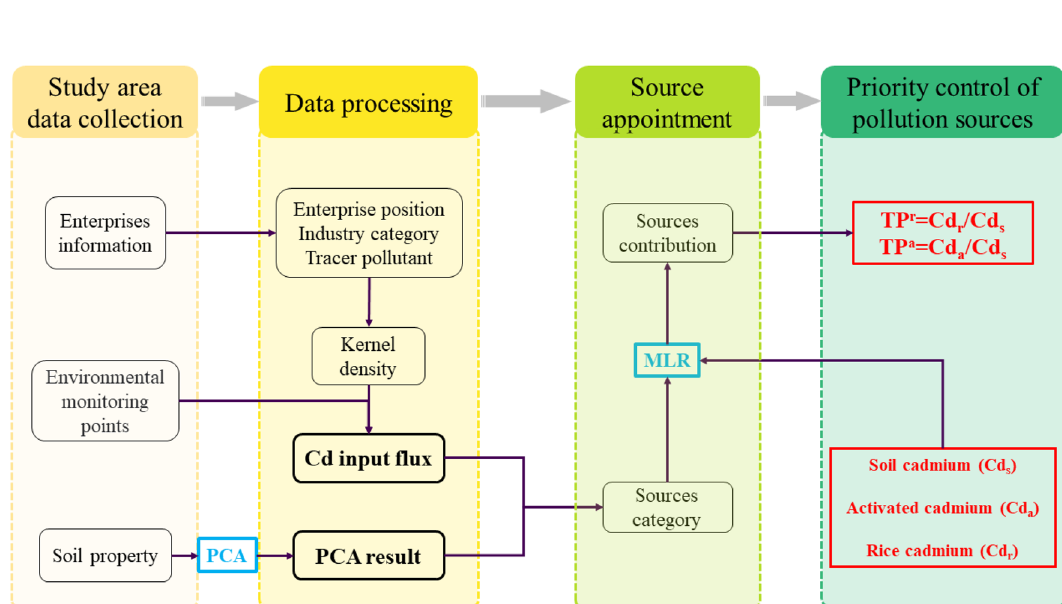
Figure 3. Workflow of the proposed hybrid framework for revealing the Cd pollution sources for priority control in soil–rice systems